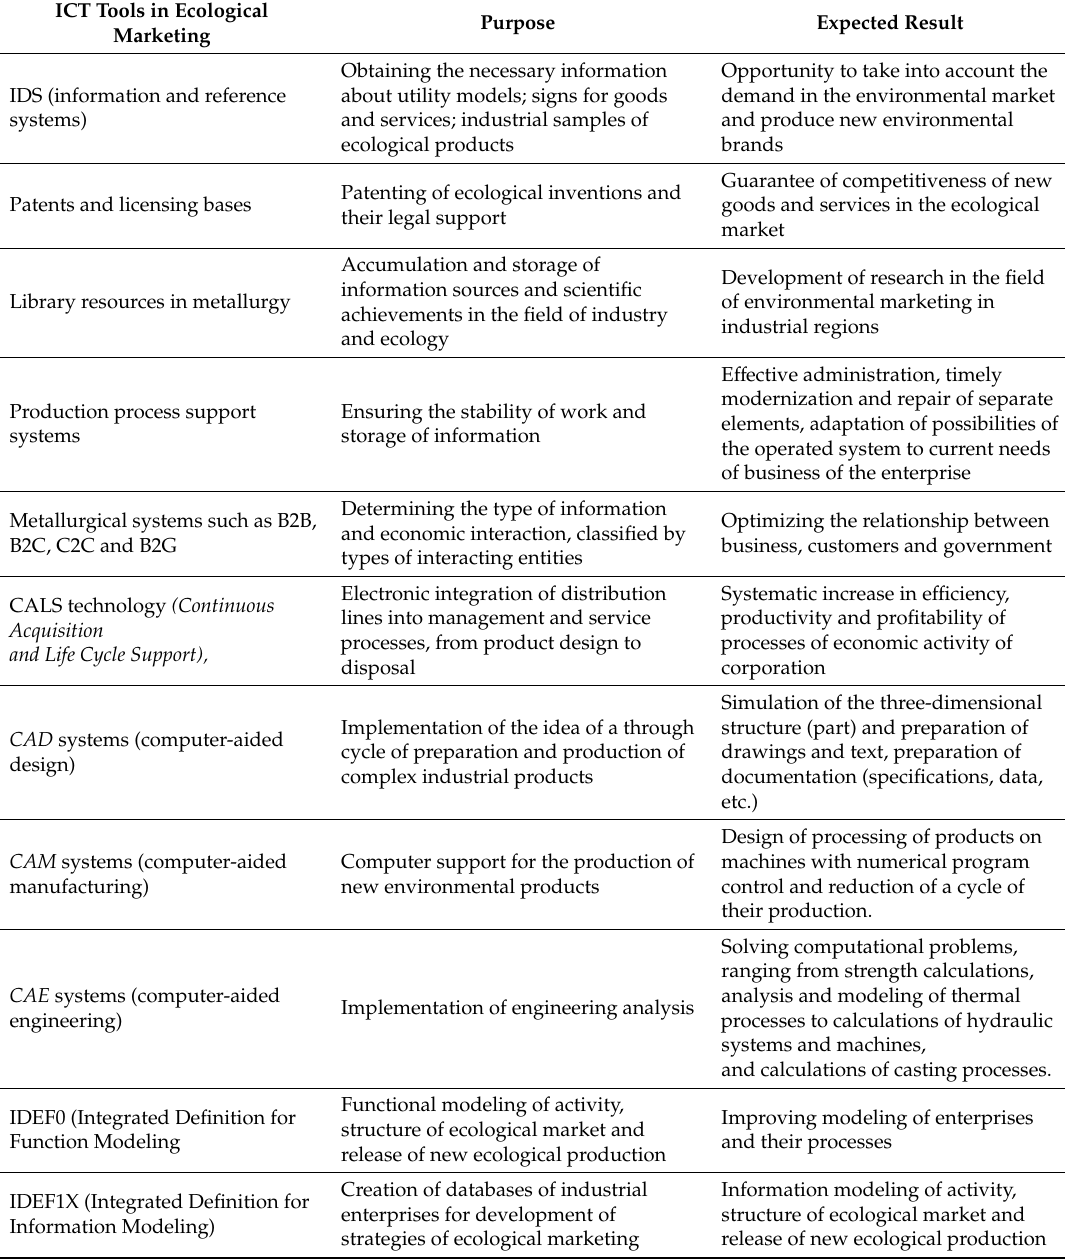
Table 1. ICT tools of ecological marketing, their purpose and expected